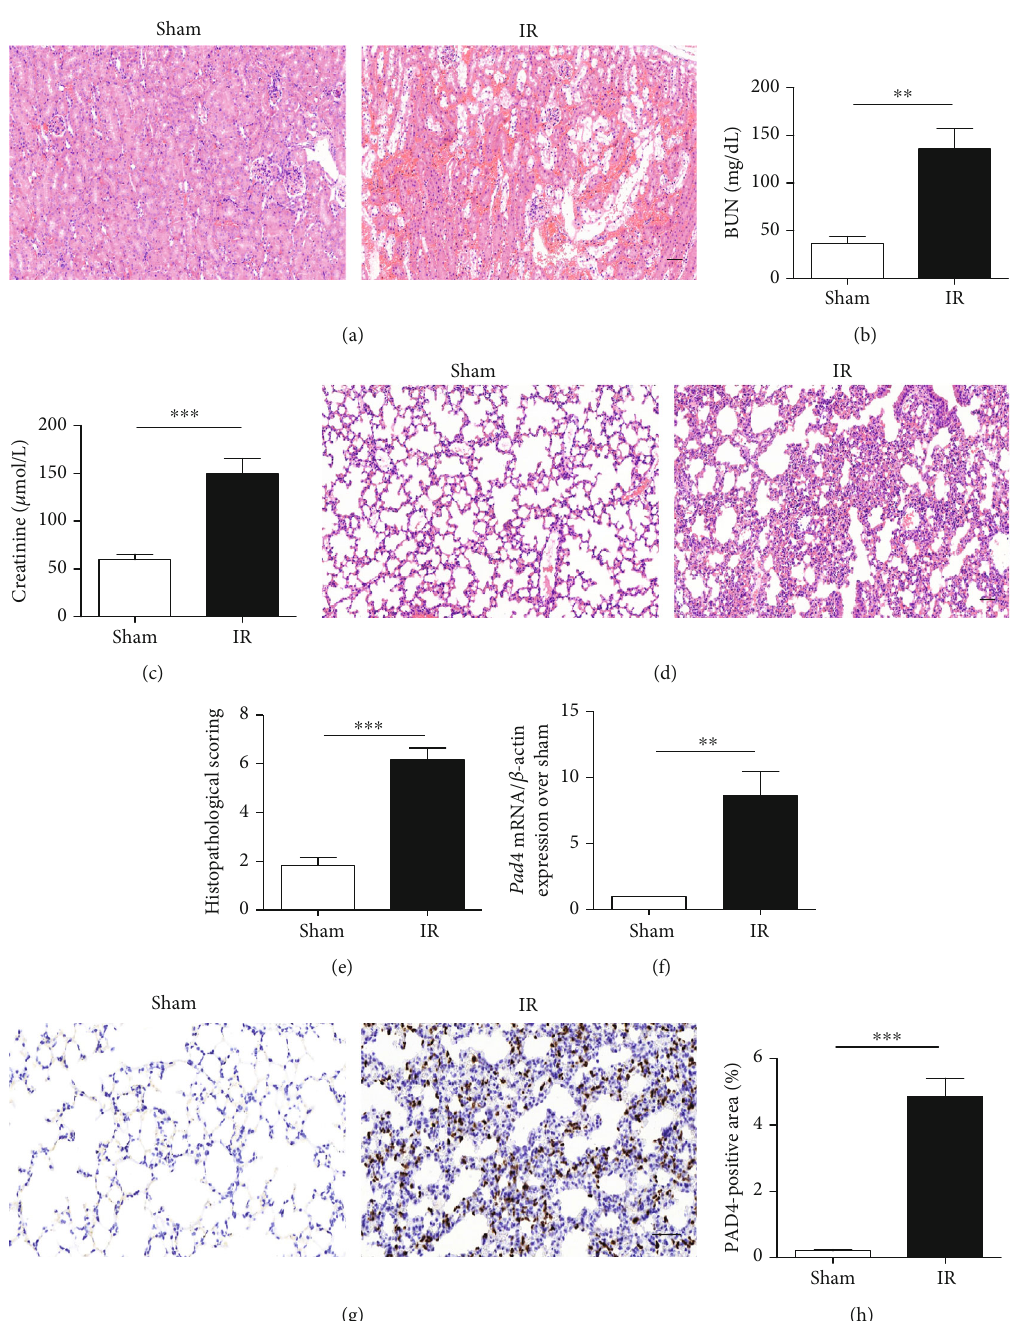
Figure 1: Kidney and pulmonary histopathological changes and lung PAD4 activity in renal ischemia-reperfusion- (IR-) treated mice. (a) Representative photographs of H&E-stained kidney samples from 24 h after renal IR injury (scale bar: 50 μ m). (b, c) Determination of blood urea nitrogen (BUN) and creatinine levels. (d) Representative photographs of H&E-stained lung sections from 24h after renal IR injury (scale bar: 50 μ m). (e) Histological analysis of lung sections. (f) The PAD4 mRNA expression measured by quantitative RT-PCR. (g) The PAD4 expression evaluated by immunohistochemistry (scale bar: 50 μ m). (h) Analysis of the PAD4 expression. The values are the means ± SEMs ; n = 6 ; ∗∗ p < 0 : 01 and ∗∗∗ p < 0 : 001